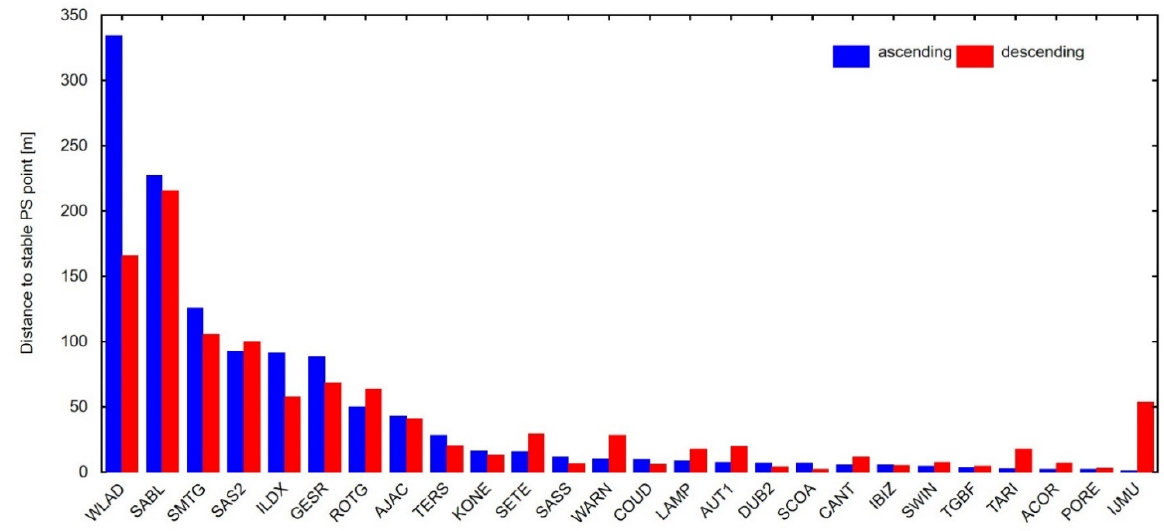
Figure 10. Distances between selected PS points from ascending and descending tracks and the GNSS station. PS targets were ordered from the longest distance (334.28 m) from the WLAD station, and the shortest distance (0.98 m) from the IJMU station.